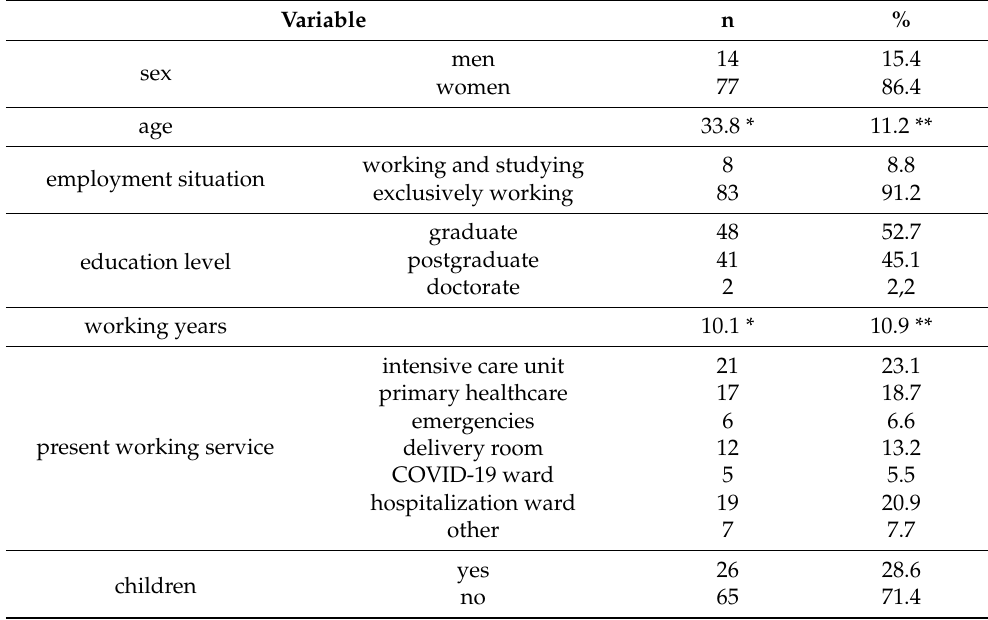
Table 1. Demographical variables of the